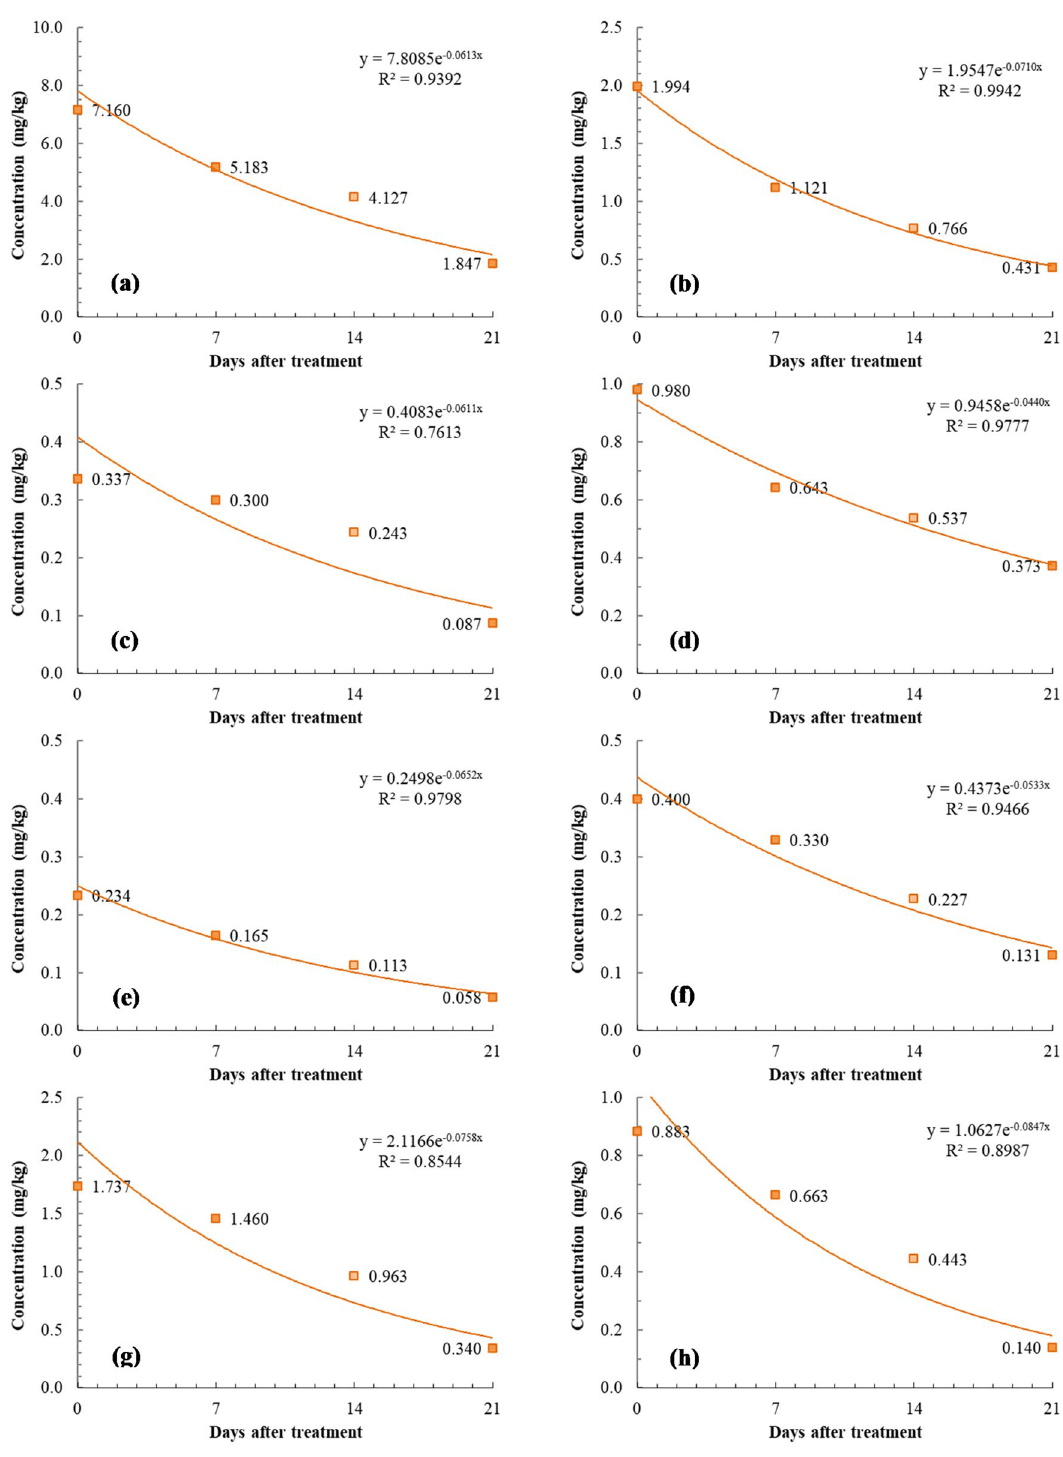
Figure 2. Dissipation patterns of pesticides in Brussels sprout. ( a ) acephate, ( b ) etofenprox, ( c ) imidacloprid, ( d ) indoxacarb, ( e ) alpha-cypermethrin, ( f ) zeta-cypermethrin, ( g ) fludioxonil, and ( h )